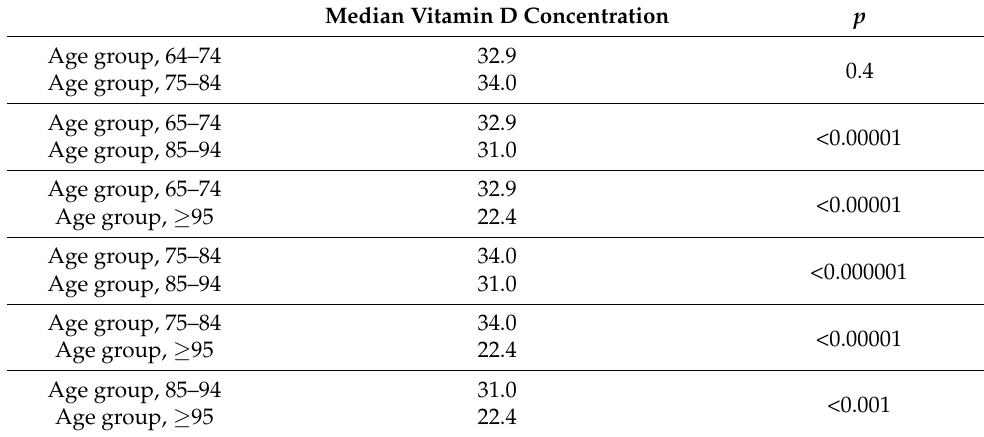
Table 5. Comparison of the median vitamin D concentration between the age groups (Kruskal– Wallis